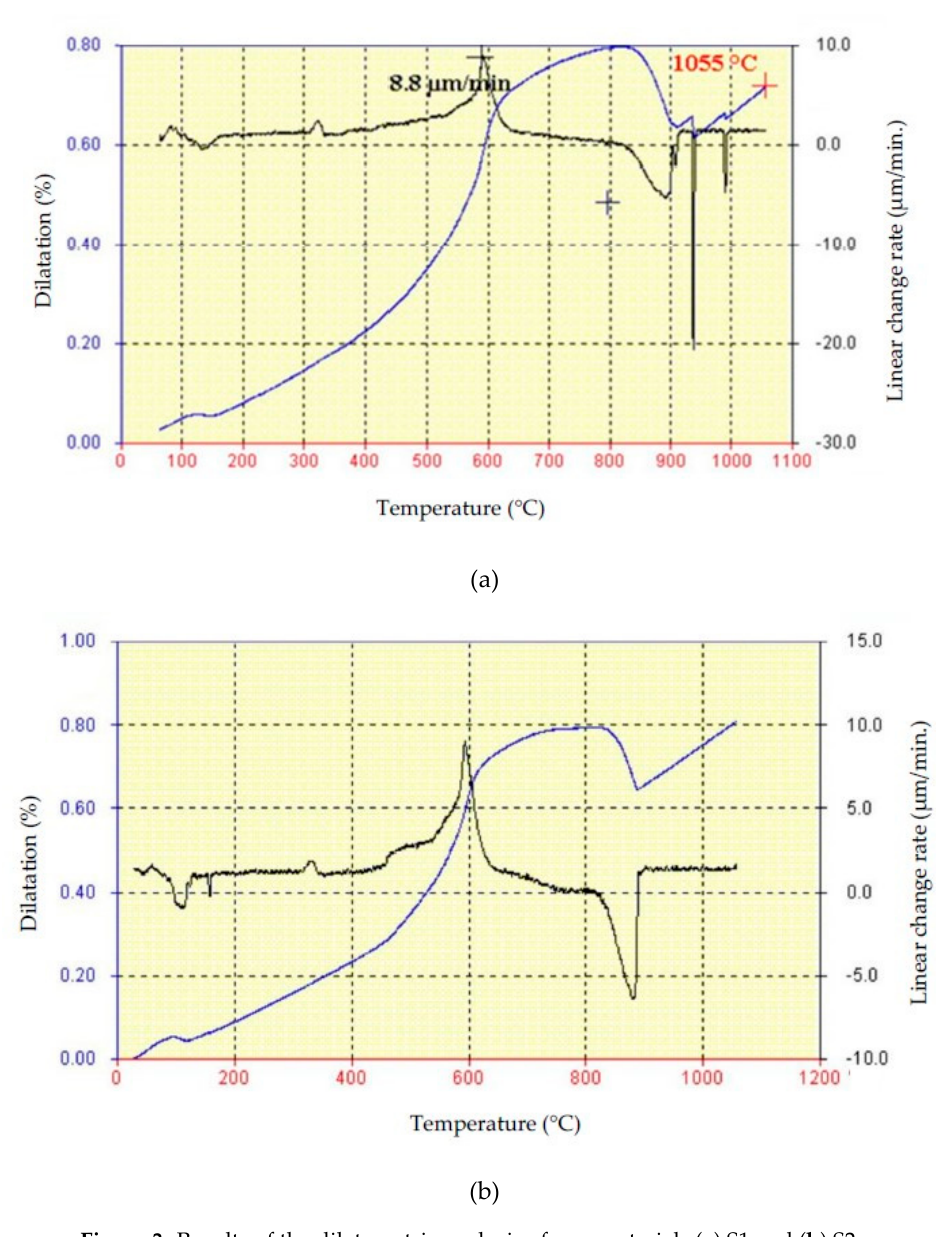
Figure 3. Results of the dilatometric analysis of raw materials ( a ) S1 and ( b ) S2.